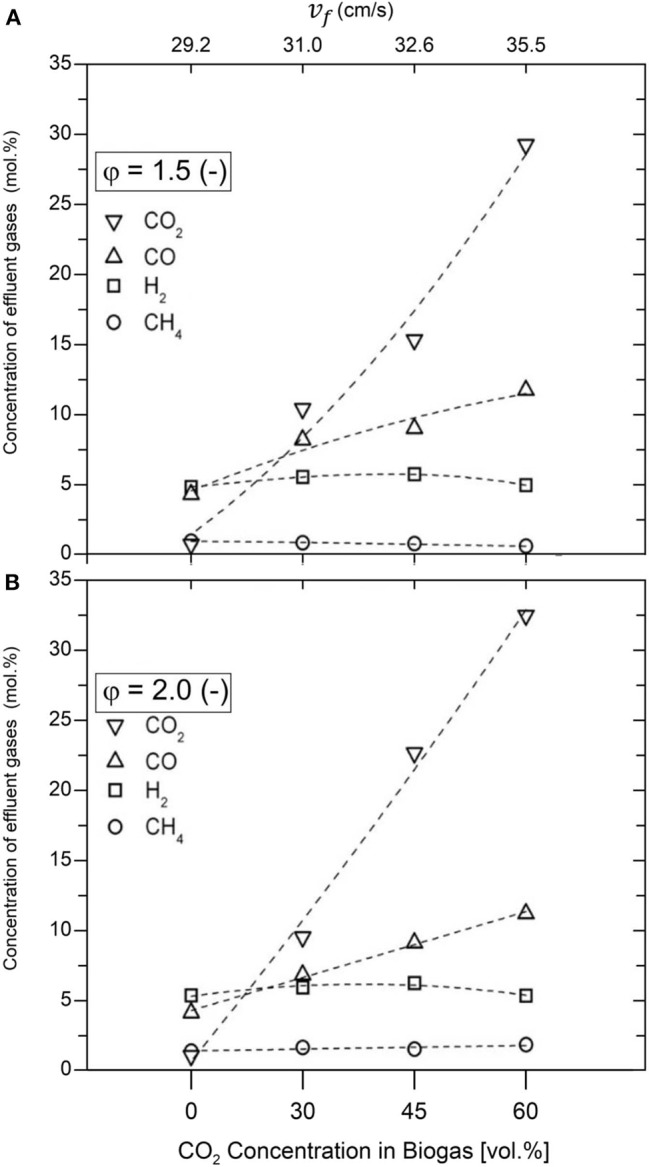
Species concentrations in produced gas (H2, CO, CH4, and CO2) for equivalence ratios φ = 1.5 (A) and φ = 2.0 (B).